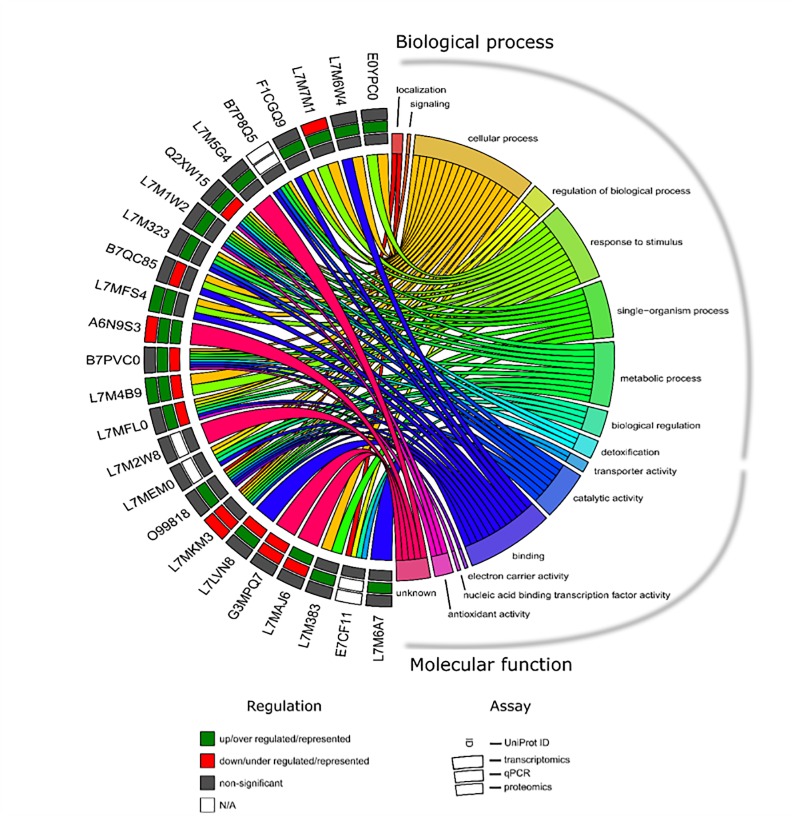
Chord diagram showing the apoptotic and stress response-related UniProt’s and its expression/representation as well as GO identified in R. annulatus in response to Babesia infection. Each target in each molecular approach is shown on the left, and the GO annotation is shown on the right including “BP” and “MF.” Outer annulus to inner annulus: transcriptomic, qPCR, and proteomic results. Green square: up/over expressed/represented; red square: down/under expressed/represented; gray square: non-significant (p > 0.05) and white square: not applicable.